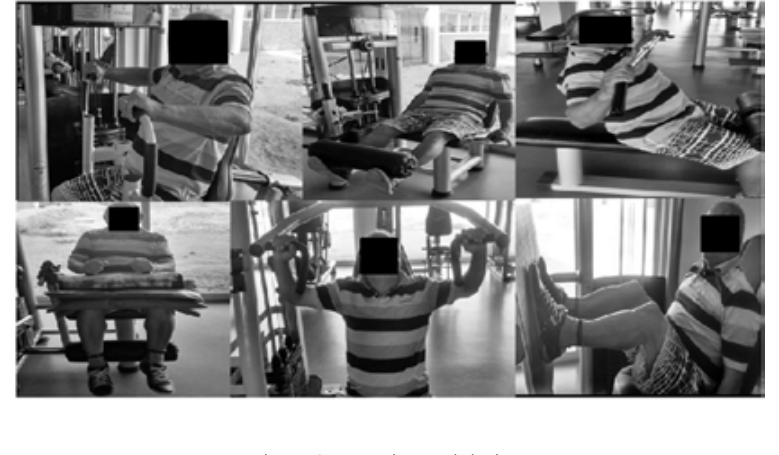
Figure 3. Experimental